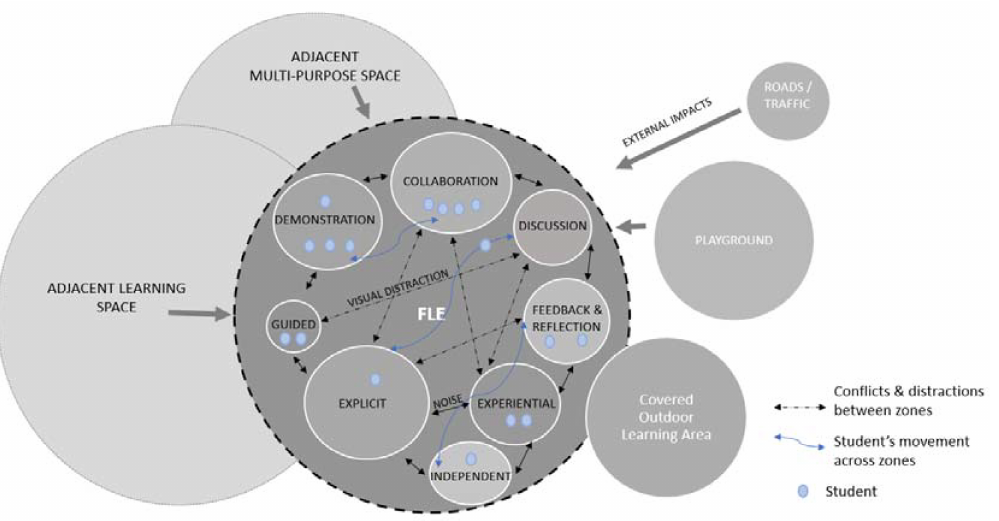
Figure 2. Design considerations need to address internal zoning and proximity of